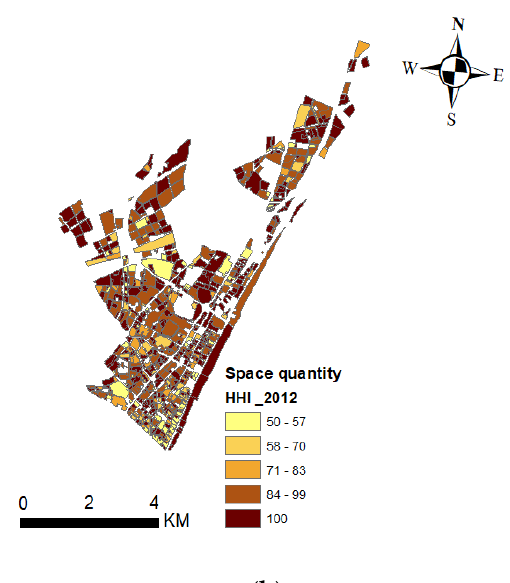
mixed land-use, while a range of 84–99 indicates a low level of mixed land-use patterns. In